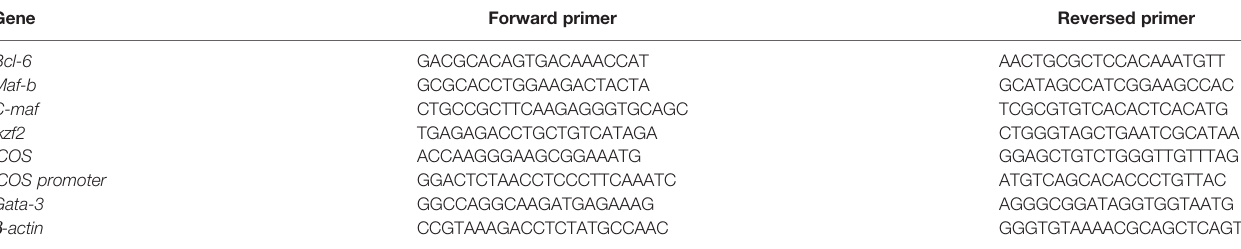
TABLE 1 | Sequences of